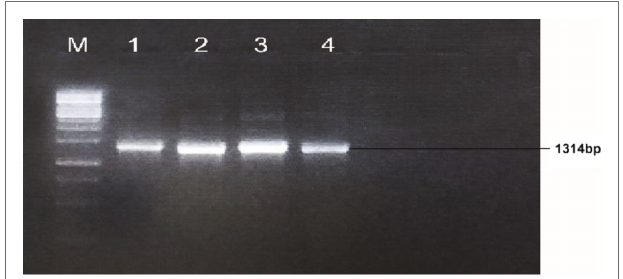
FIGURE 1 | Identification and isolation of Gh_A07G1537 gene from CCRI45, Hai1 and MBI7747; Lane M: 1 kb DNA ladder; Lane 1: amplification from cDNA of CCRI45; Lane 2: amplification from Hai1; Lanes 3 and 4: amplification from the cDNA of genotype